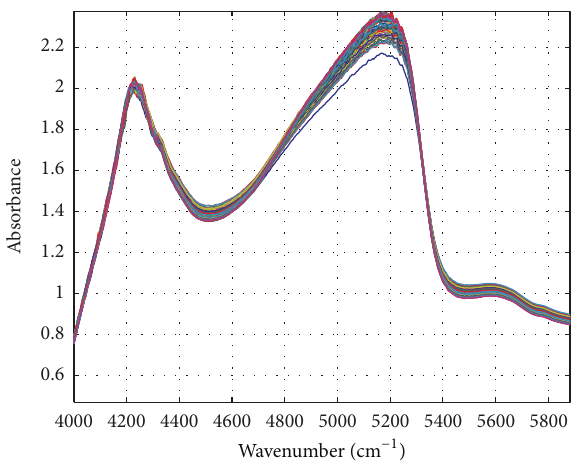
Figure 1: The NIR spectra of all experimental milk